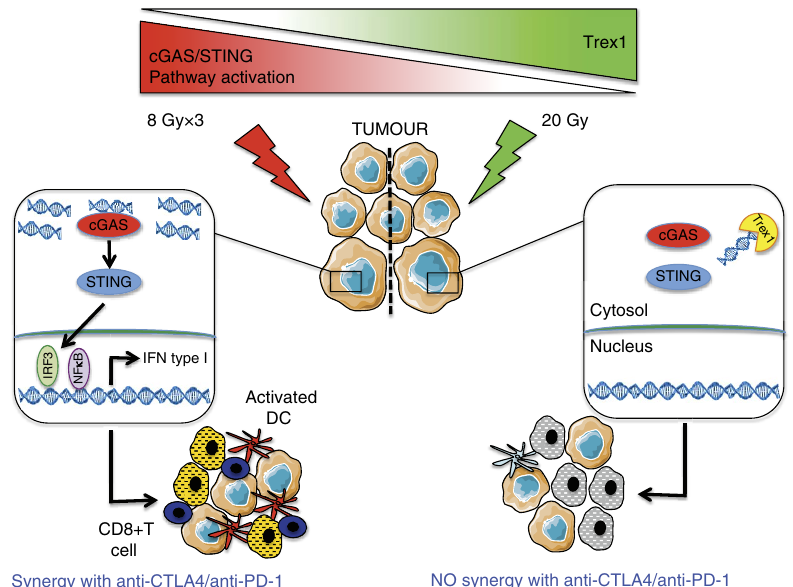
Figure 9 | Graphical summary. Left, treatment with a radiation regimen that causes dsDNA accumulation in the cancer cells cytosol without inducing the DNAse Trex1 activates interferon type-I pathway via cGAS/STING. Downstream recruitment of DC and activation of CD8 þ Tcells is enabled and tumour rejection occurs in synergy with anti-CTLA4 or anti-PD-1 antibody. Right, in tumour treated with a dose of radiation above the threshold for Trex1 induction dsDNA is cleared from the cytosol precluding interferon- b release by the cancer cells. This leads to insufficient DC recruitment and activation and lack of CD8 þ T cell activation resulting in absence of local and abscopal tumour regression in combination with immune checkpoint Cells and reagents . BALB/c mouse-derived poorly immunogenic mammary carcinoma 4T1 and TSA cells were obtained from F. Miller 37 and P.L. Lollini 38 , respectively. C57BL/6 mouse-derived poorly immunogenic colorectal carcinoma MCA38 was a gift of Alan Frey 39 . MDA-MB-231 and 4175TR human triple negative breast cancer cells were purchased from ATCC and obtained from J. Massague, respectively. All cells were authenticated by IDEEX Bioresearch (Columbia, MO, USA), and further by morphology, phenotype, growth and pattern of metastasis in vivo and routinely screened for Mycoplasma (LookOut Mycoplasma PCR Detection kit, Sigma-Aldrich). None of the cells used are listed in the International Cell Line Authentication Committee (ICLAC) database of commonly misidentified cell lines. TSA, 4T1, MCA38 and MDA-MB-231 and 4175TR were cultured in DMEM (Life Technologies)